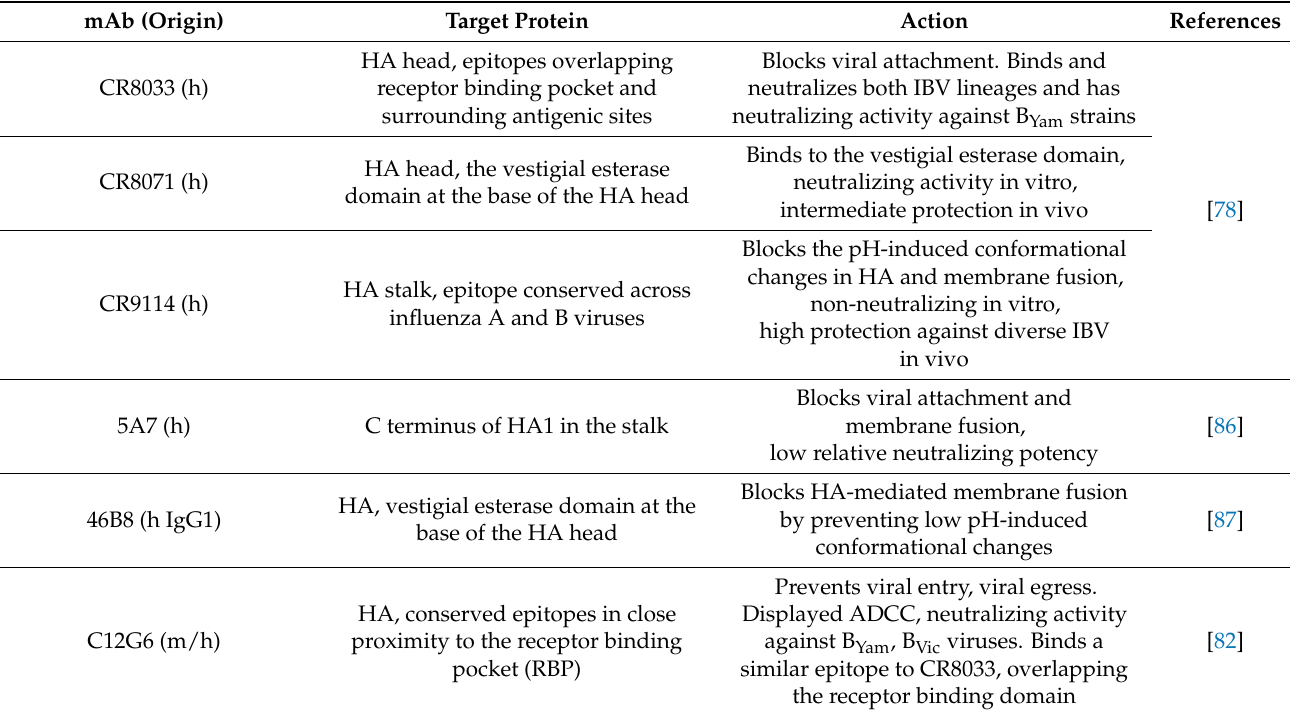
Table 1. Cross-reactive monoclonal antibodies against influenza B